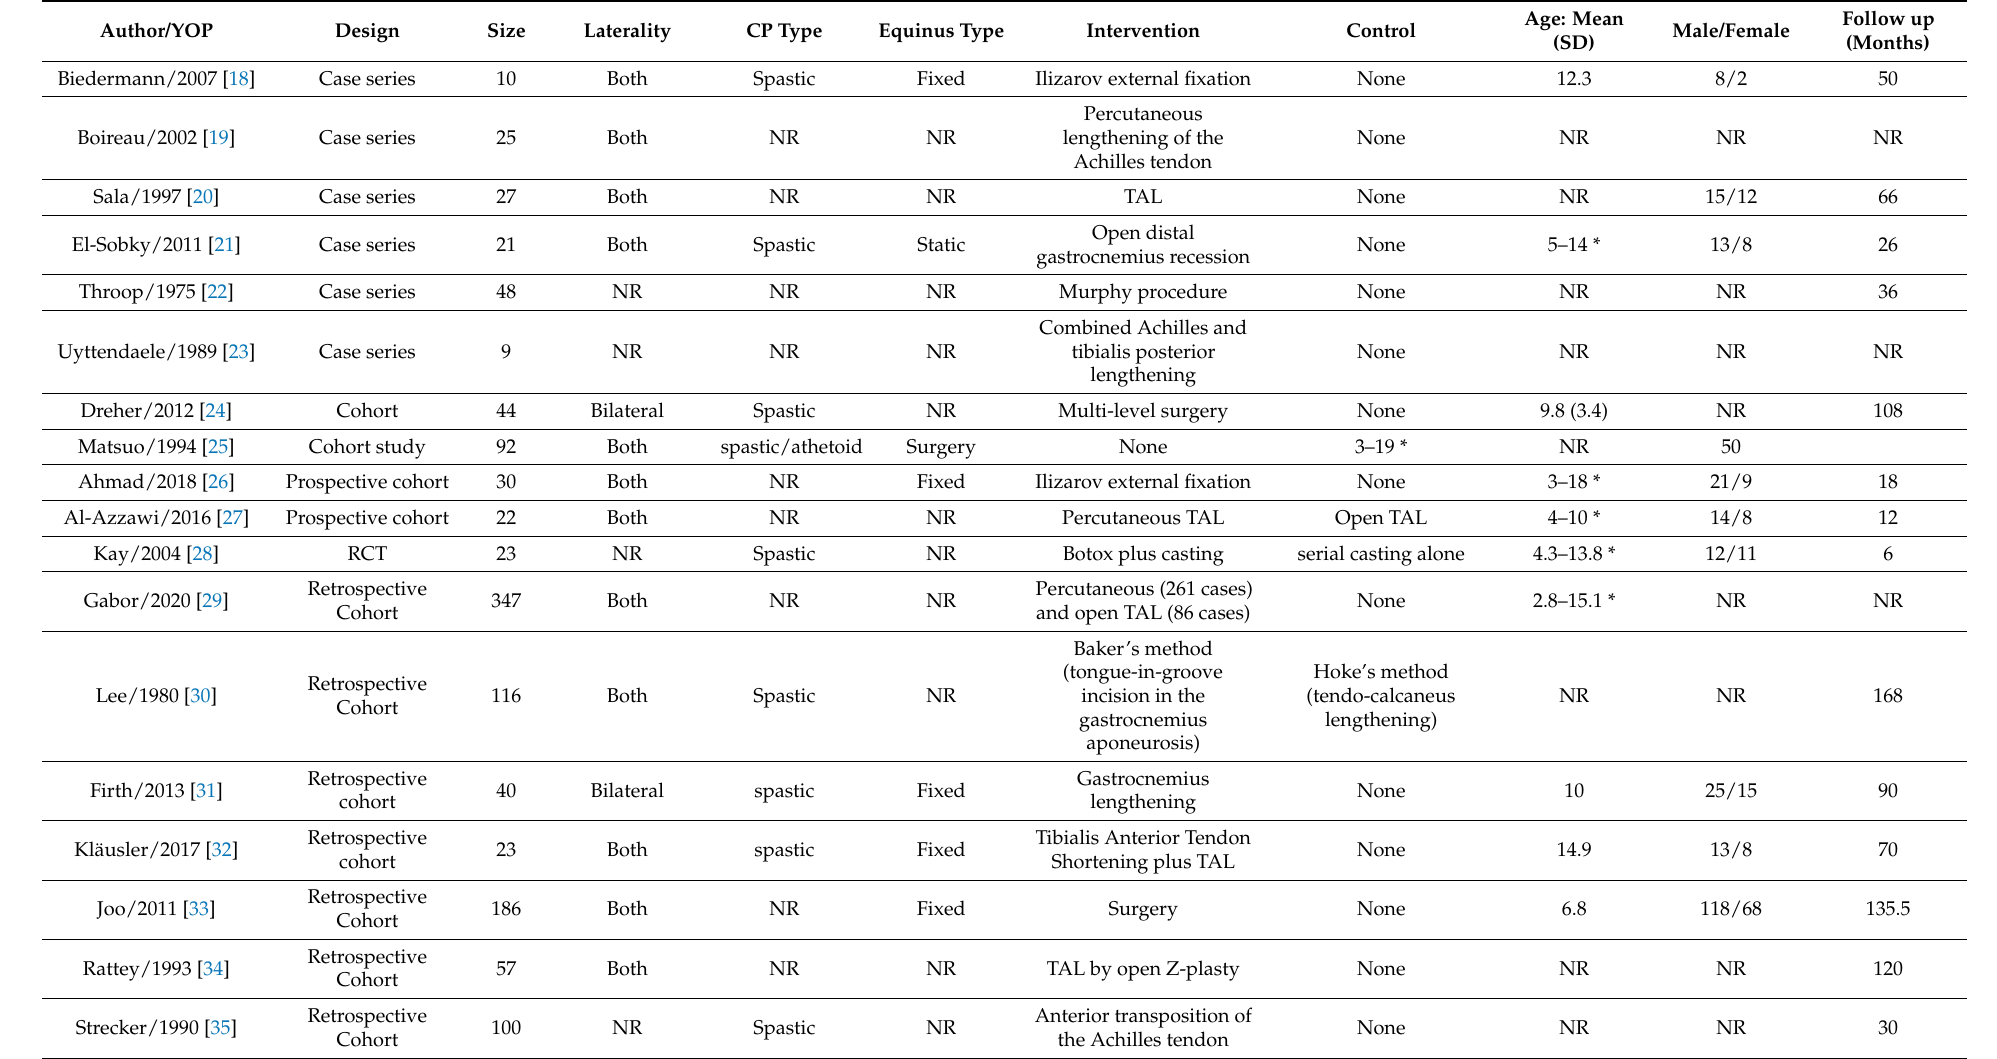
Table 1. Baseline characteristics of studies included in the systematic review (N =